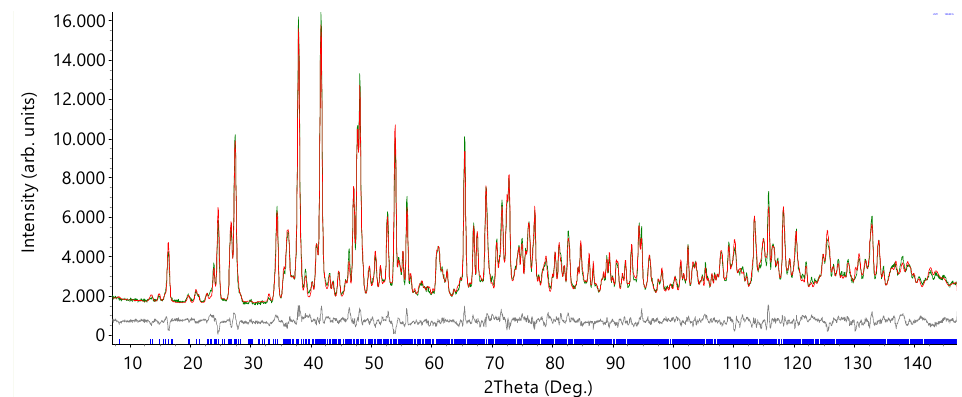
Figure 4. The final Rietveld diagram of La 0.987 Ti 1.627 Nb 3.307 O 13 on the neutron diffraction pattern. The measured (blue) and calculated (red) lines are superimposed, while the gray line below represents the difference. Vertical bars at the bottom mark the reflection positions. Table 1. Crystal data and Rietveld refinement parameters of La 0.987 Ti 1.627 Nb 3.307 O 13 .